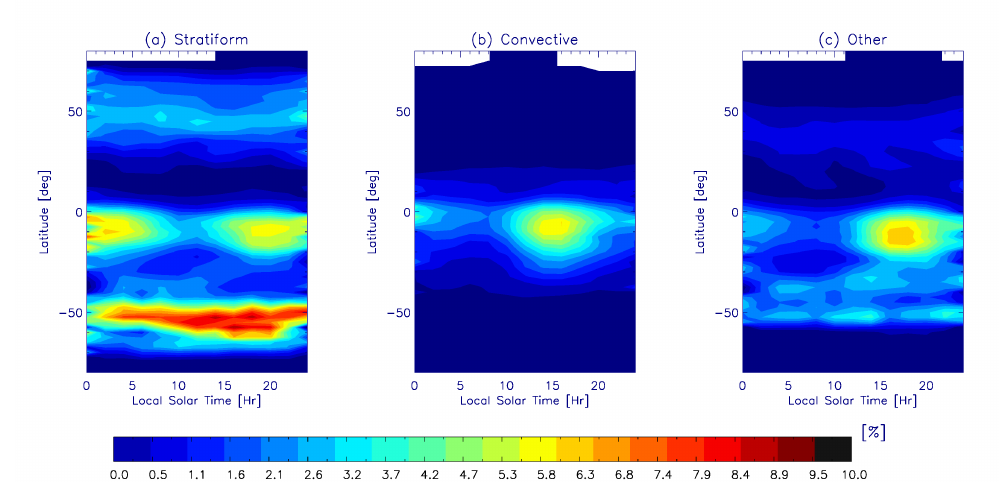
Figure 12. Diurnal variation of cloud fraction (%) from GMI-only prediction during DJF, 2016 and 2017 for ( a ) stratiform, ( b ) convective, and ( c ) other precipitation classes, respectively.